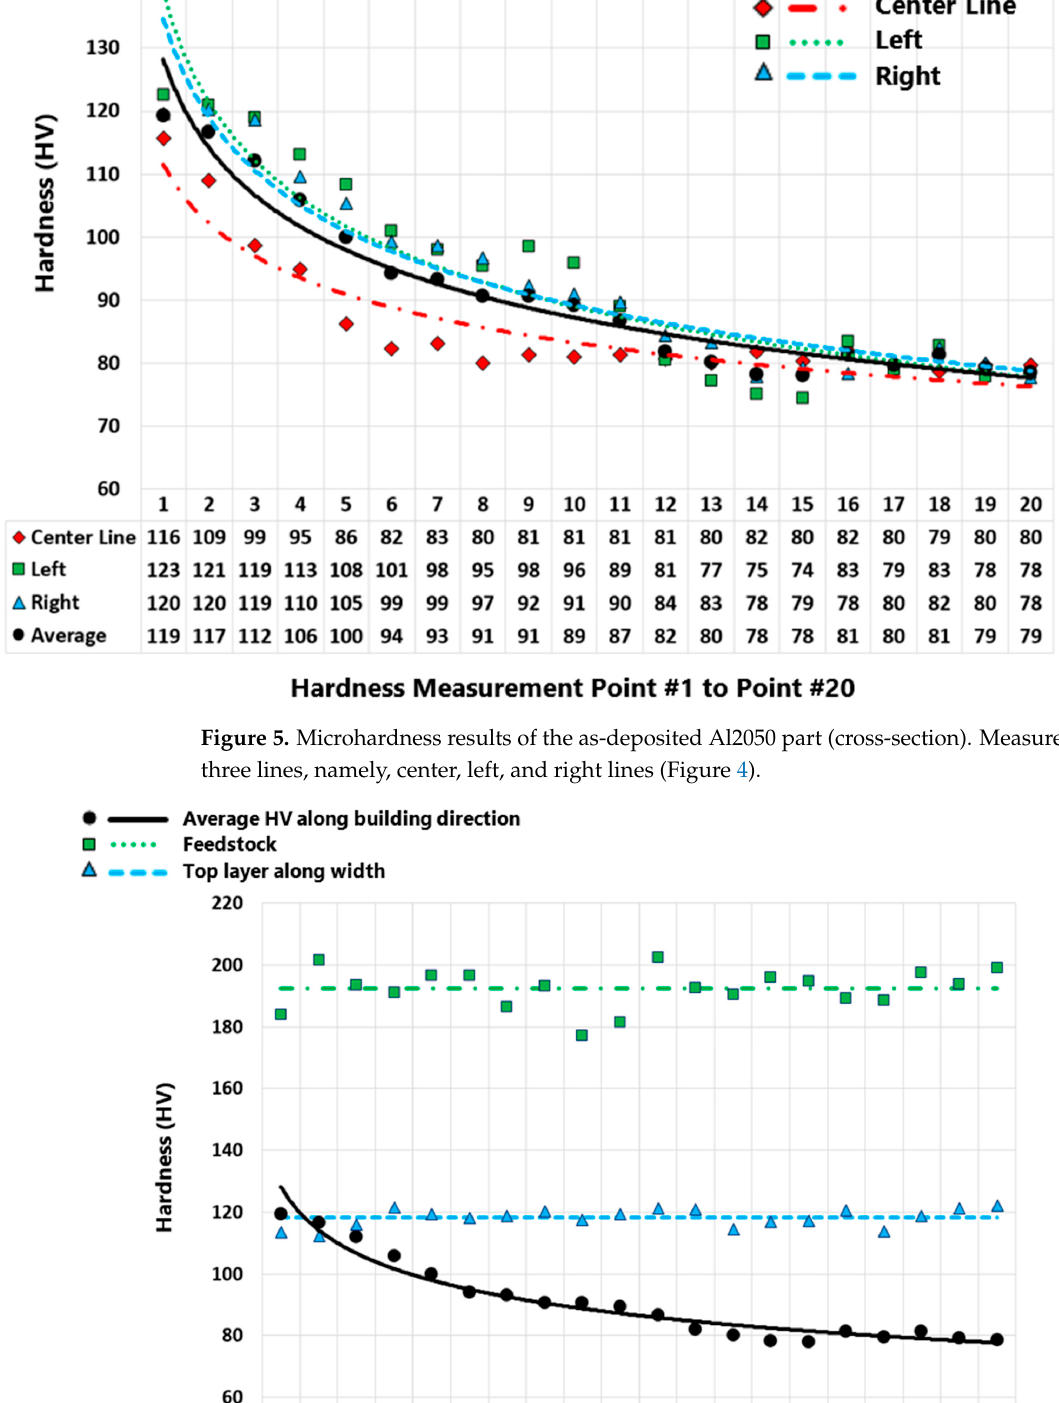
± 2.90 HV, which is significantly smaller than the one for the feedstock (192.32 ± 6.52 HV).